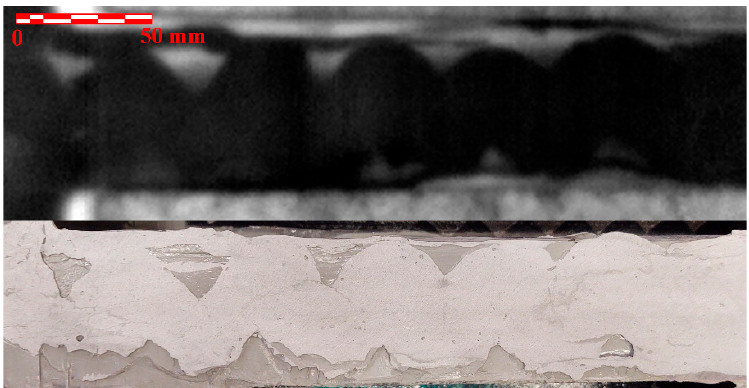
Figure 20. Comparison of NDE findings in the end of the wing spar area ( top ) with the actual condition of the adhesive joint ( bottom ).